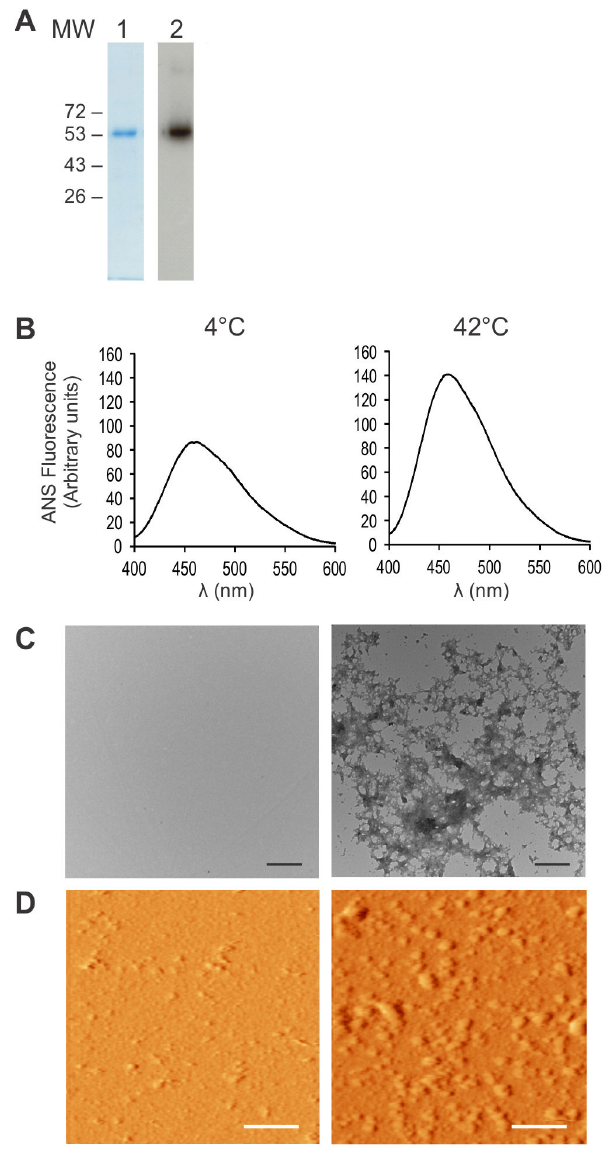
Figure 1. p53 forms amorphous aggregates at 42 °C. (A) Purified p53 protein were resolved by 10% SDS-PAGE and stained with Coomassie Blue (lane 1) or analyzed by Western Blot (lane 2). (B) 5 µM p53 protein was left at 4 °C (soluble) or heated at 42 °C (aggregates) for 24 h and analyzed by ANS fluorescence (C) Transmission electron microscopy showing mostly soluble (incubated at 4°C) or aggregated (incubated at 42°C) p53. (D) Atomic force microscopy showing mostly soluble (incubated at 4°C) or aggregated (incubated at 42°C) p53. Scale bars: 500 nm (C) and 1 µm